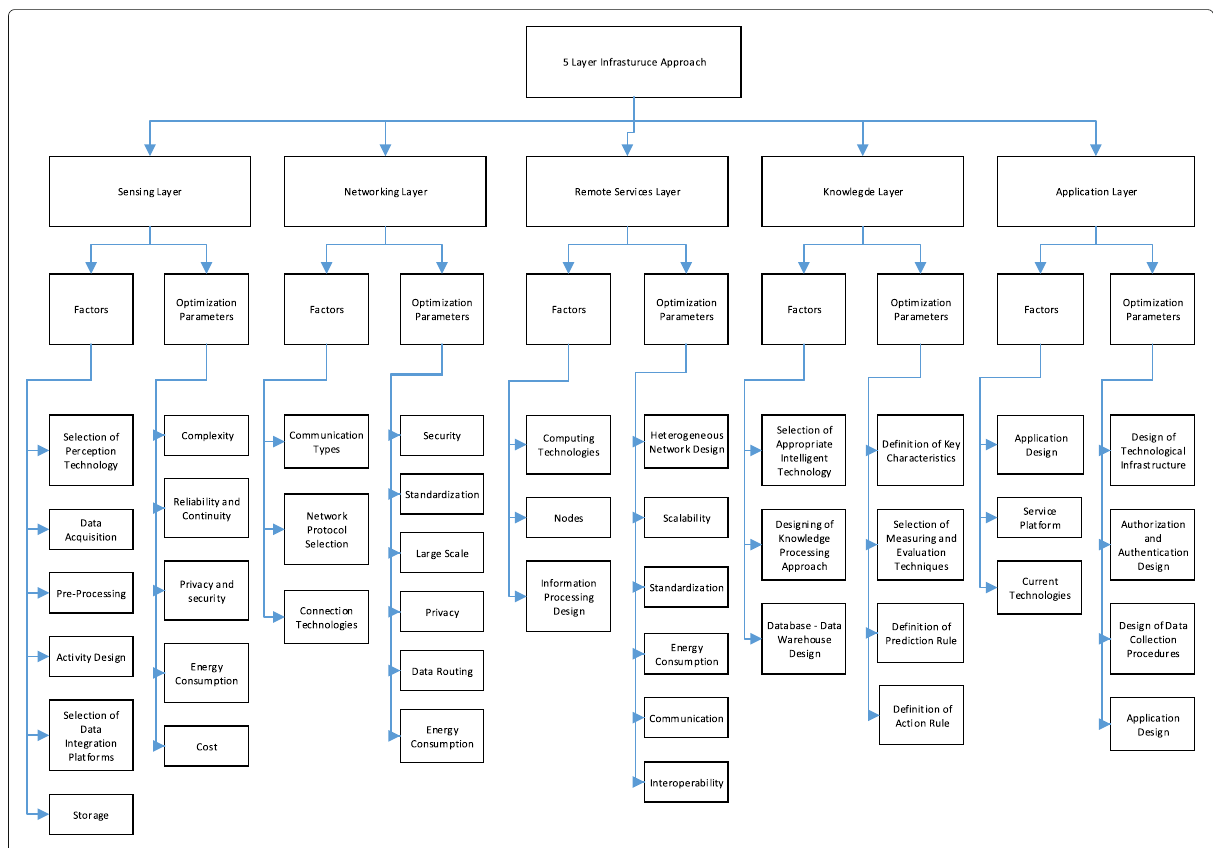
Fig. 1 Taxonomy diagram of proposed five layered IoT architecture vice models were evaluated by the stake-holders. These brand-new service models have significantly increased the efficiency of hospital staff and offered improvements in healthcare